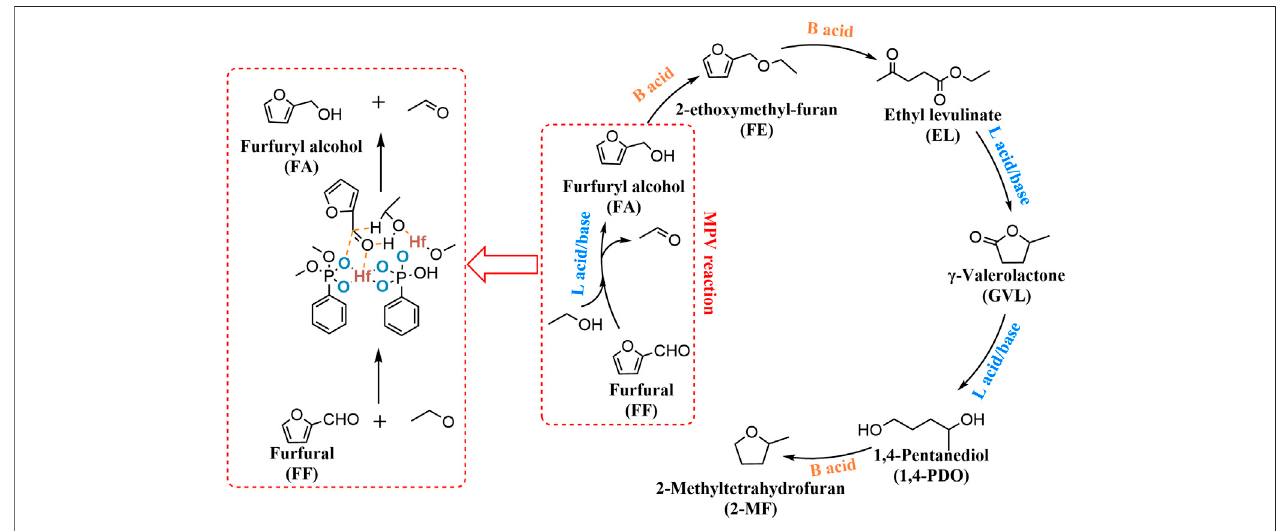
SCHEME 7 | Mechanism of FF to GVL over